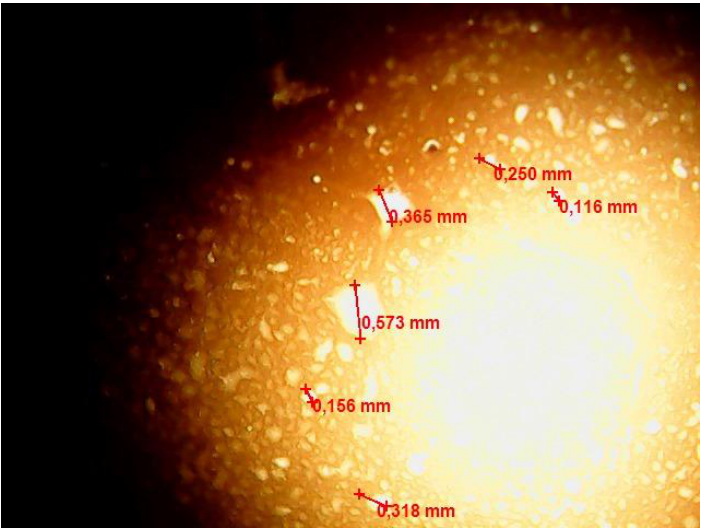
Figure 7. Optical microscopic image of the w/o emulsion sample after contact with the FMQ particles for 60 min.